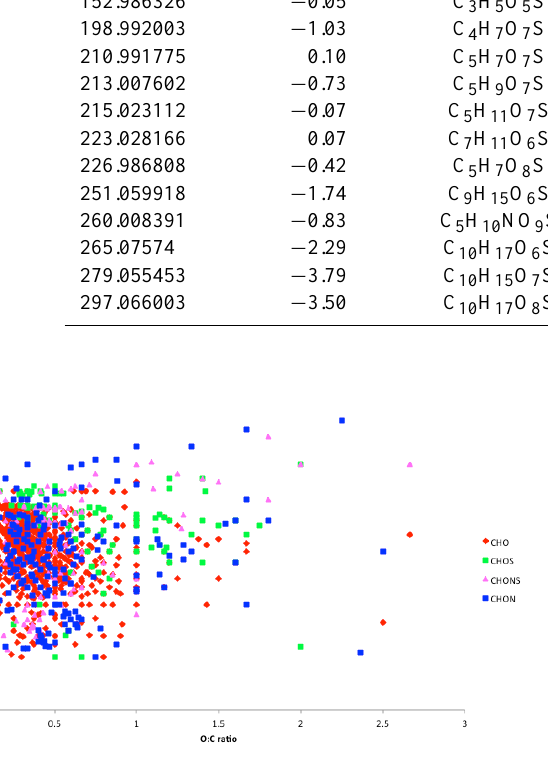
Fig. 2. Van Krevelen plot of calculated O:C and H:C ratios from the Borneo rainforest OA sample extract determined using FTICR. Red=CHO compounds. Blue=CHON compounds. Green=CHOS compounds. Pink=CHONS